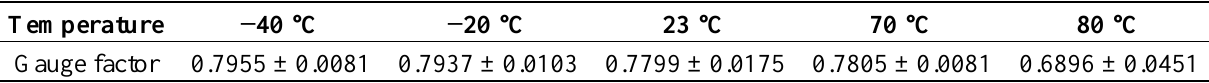
Table 1. Strain gauge factors determined from combined temperature and loading cycles.